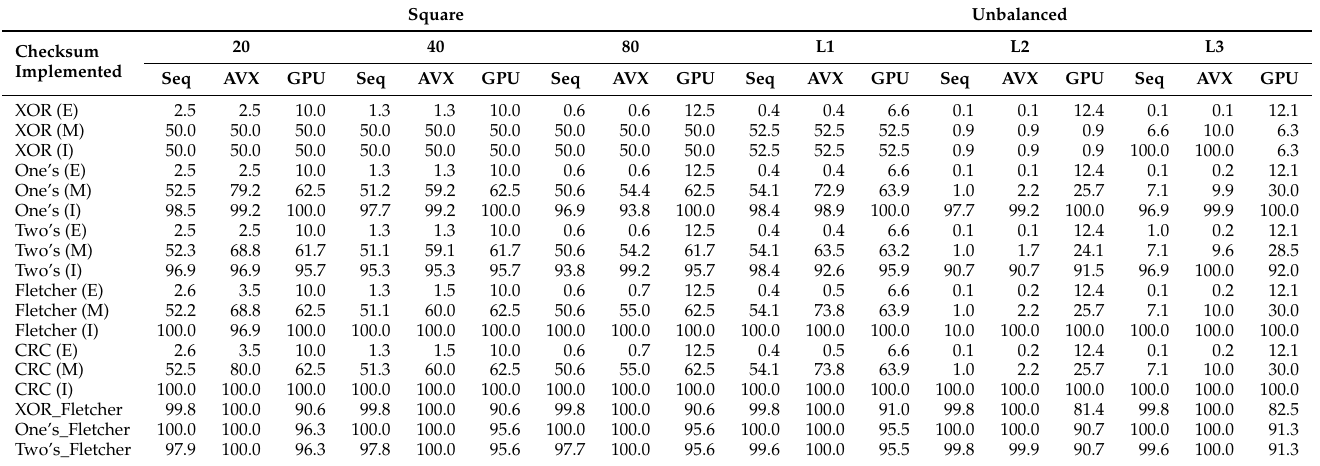
Table 3. DC in sequential [14], AVX-based [14], and GPU-based implementations. Square